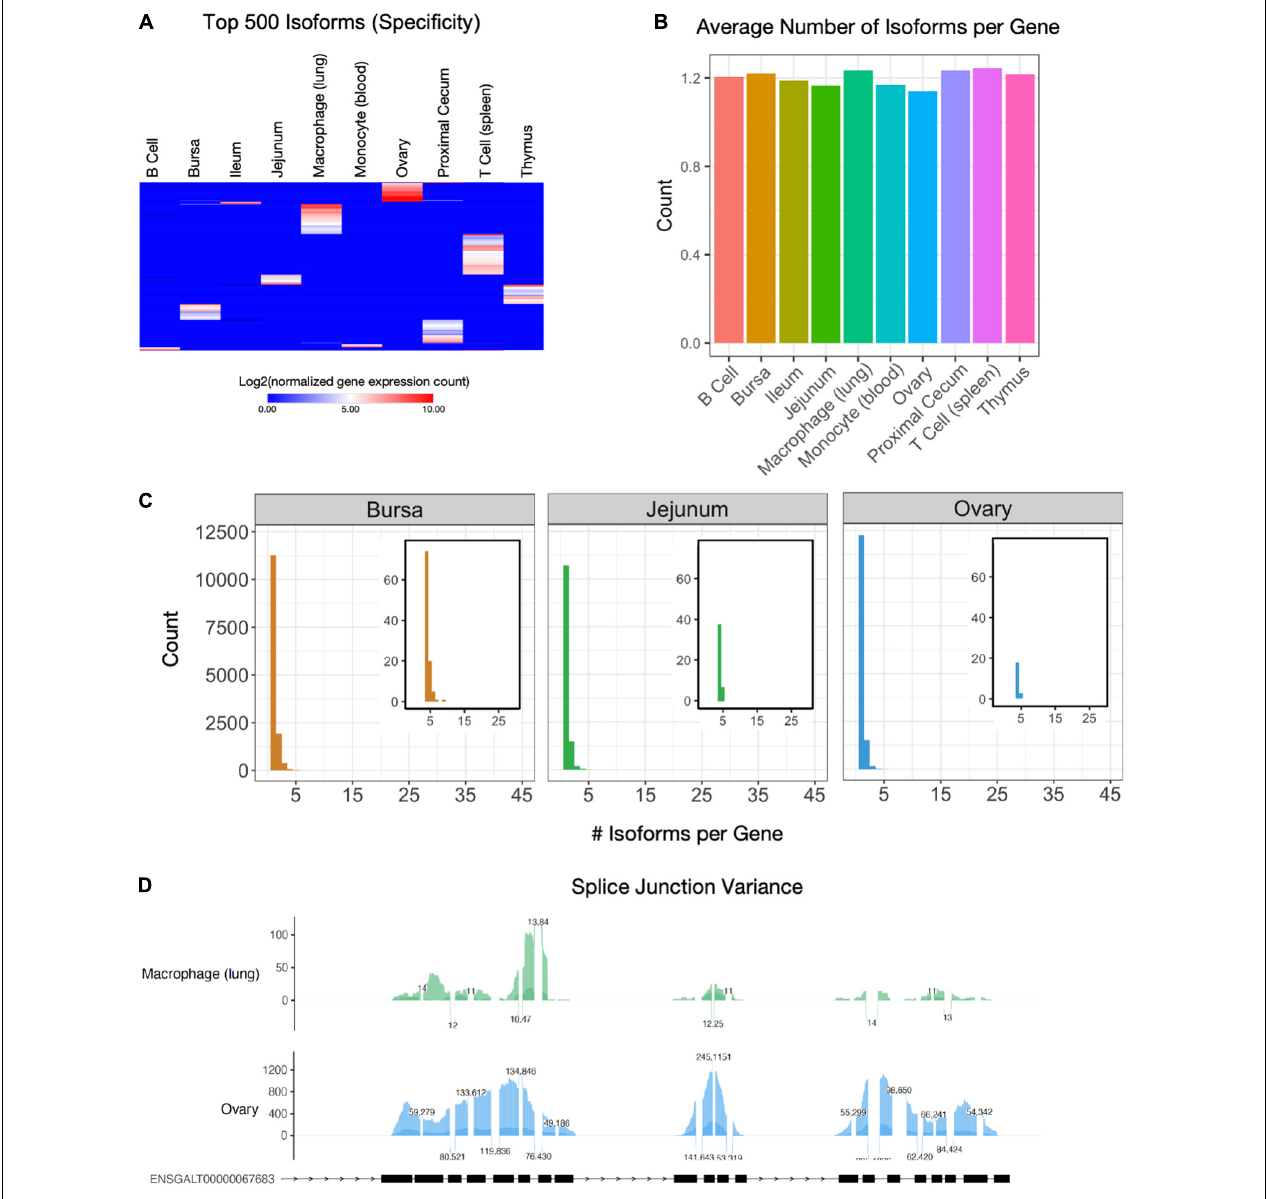
FIGURE 3 | Isoform characterization. (A) Expression of the 500 isoforms with the highest Shannon’s entropy values. Rows sorted using Euclidean distance. Isoforms have been filtered for genes that have a TPM of at least 0.5 in at least two cell types. (B) The average number of isoforms per gene for each cell type. (C) Histogram of isoform counts per gene. The cutout plot in the upper-right corner is a zoomed-in section for 4+ isoforms per gene. (D) Sashimi plots of splice junction variance for macrophage (lung) cells and ovary tissue for gene PDGFRB (ENSGAL00000030613), which has a single annotated transcript ENSGALT00000067683.